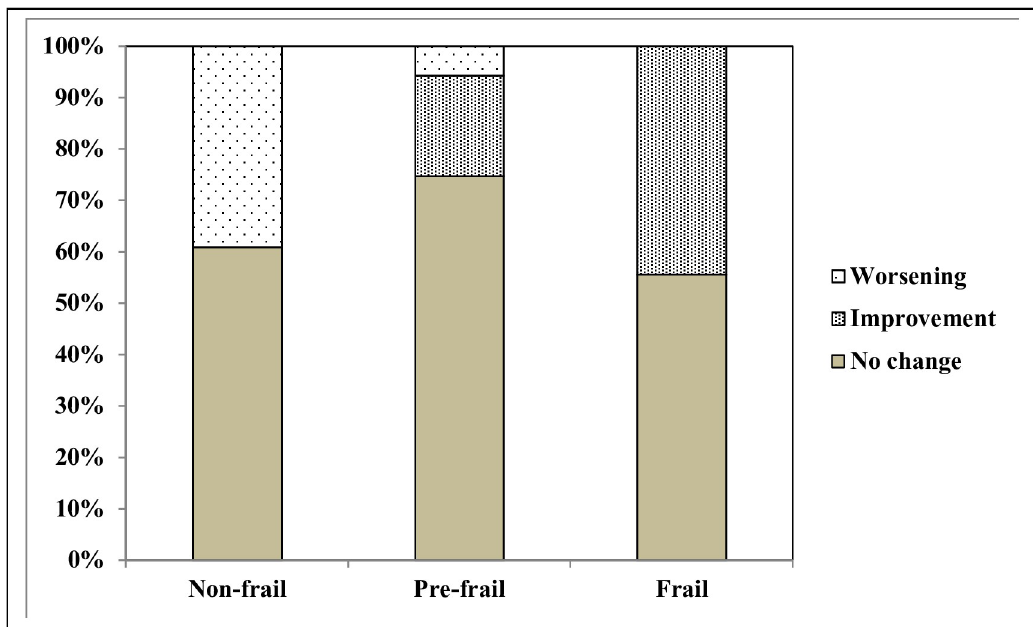
Fig 1. Frailty transitions according initial frailty status.